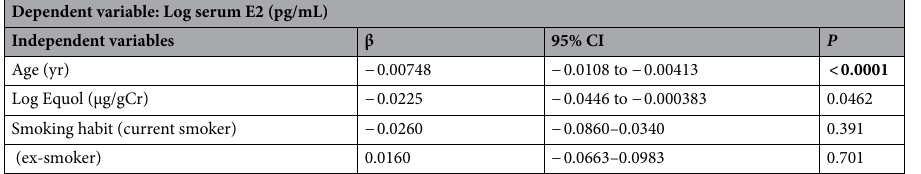
Table 4. Analysis of covariance of the association between serum estradiol and urinary equol levels. CI: confidence interval. Analysis of covariance was conducted for log serum E2 as dependent variable with independent variables (log equol, age and smoking). Tobacco use was coded as 1 = non-smoker, 2 = current smoker, and 3 = ex-smoker. Model fitness, R 2 = 0.233. IQR increase in equol (4.51 μg/gCr to 189 μg/gCr; 41.8- fold) was associated with 0.919-fold lower serum E2